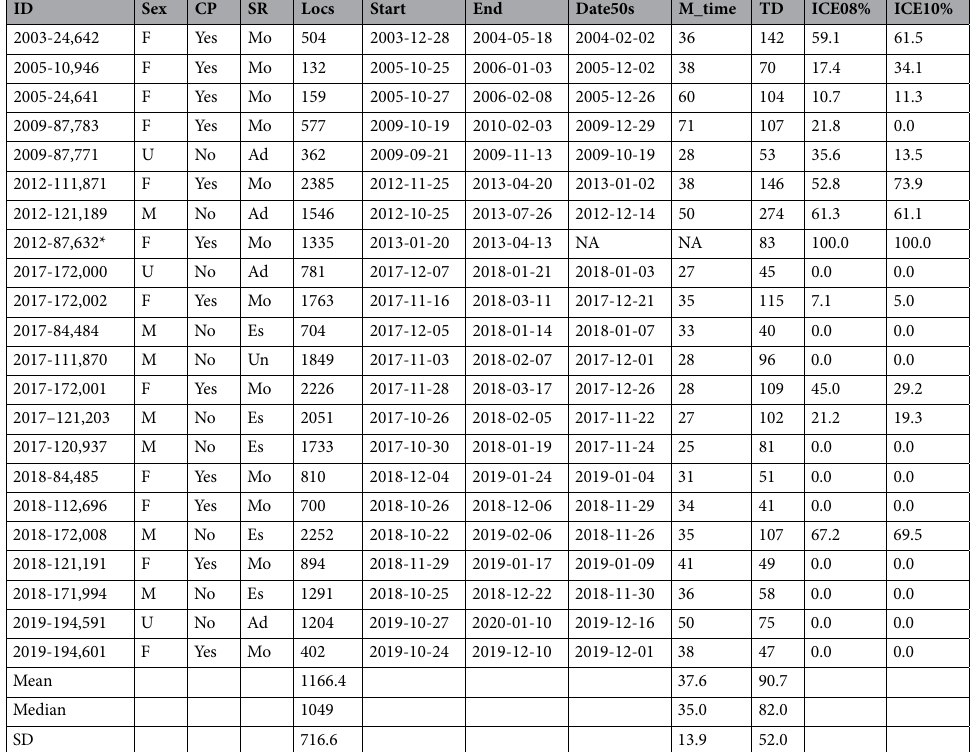
Table 1. Summary of satellite tag deployments and tracking data for 22 humpback whales used during analyses. The first four digits on the identification code (ID) correspond to tagging year. The sex column denotes whether whales were female (F), male (M) or undetermined (U). CP indicates calf presence. SR denotes the social role of each whale, with four possible categories, mother (Mo), adult (Ad), escort (Es) and undetermined (Un). Locs correspond to the number of individual positions available for each whale. Start and End correspond to the date range of tracking duration after removing locations on Brazilian shelf areas (before migration onset). The date each whale crossed 50°S (date50S) and the number of days this migratory displacement lasted (M_time) are also provided. TD correspond to tracking duration expressed in days. ICE08% and ICE10% correspond to the percentage of the data located in areas with sea ice coverage during August and October, respectively. Asterisk denotes a whale that presented a large data gap during migration, henceforth analyzed tracking data is entirely located south of the Polar Front. egory included only females, which were all adults accompanied by calves (mothers). The second category was more heterogeneous and included males and those of undetermined sex, with different social roles (males +). Oceanographic covariates. Chlorophyll- a (CHL), sea surface temperature (SST), sea surface tempera- ture anomaly (SSTA), wind stress curl (CURL), sea ice fraction, and depth data were extracted using R package rerddapXtracto 51 , which accesses the ERDDAP server at the NOAA/SWFSC Environmental Research Division. CHL data were retrieved from satellite level-3 images from the Moderate Resolution Imaging Spectroradiom- eter (MODIS) sensor onboard the Aqua satellite (Dataset ID: erdMH1chlamday), corresponding to monthly averages. For SST, SSTA and sea ice fraction, data were obtained from daily averages of level-4 satellite images derived from the Multi-Scale Ultra-High Resolution (MUR) SST Analysis database (Dataset ID: jplMURSST41 for SST and sea ice fraction; Dataset ID: jplMURSST41anom1day for SSTA). MUR-SST maps merge data from different satellites, combined with in situ measurements, using the Multi-Resolution Variational Analysis statis- tical interpolation 52 . Daily SSTA are constructed as the difference between daily SST data and the daily mean SST from a climatology ranging from 2003 to 2014. CURL data (Dataset ID: erdlasFnTran6_LonPM180) is calculated from geostrophic winds based on U.S. Navy Fleet Numerical Meteorology and Oceanography Center analyzed fields of sea level pressure and is provided on a 6-hourly basis. Sea ice fraction data are provided daily in a scale from 0 to 1. As most of these data were zeros during whales´ migratory displacements, we generated new binary data, with one indicating the presence of sea ice over a ten-day sample (evenly spaced) during August (ICE08) and October (ICE10) of each year. In addition, we retrieved the average position of the Southern Boundary of the Antarctic Circumpolar Current (SBACC) from the Committee on the Earth Observation Satellites (CEOS). This processed file is made available by the Australian Antarctic Data Centre, through CEOS, based on data